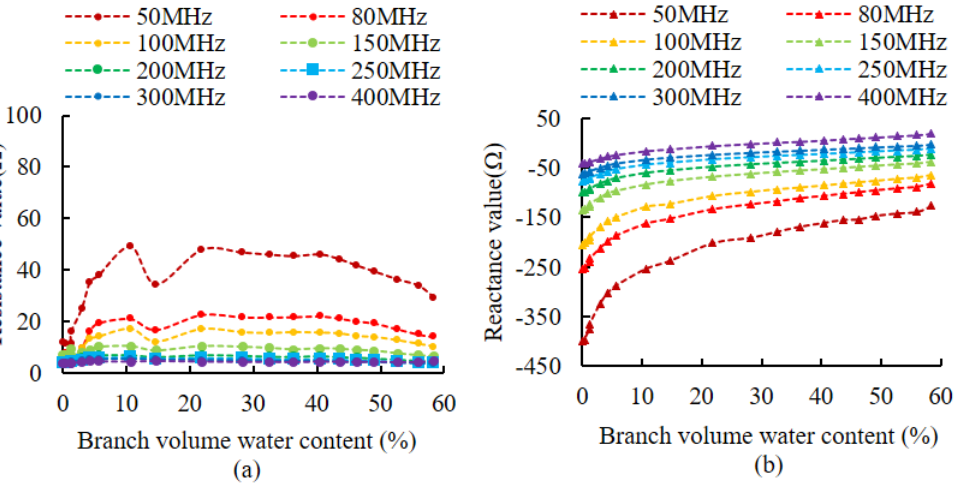
Figure 8. The variation of the impedance of the live wood branches. ( a ) The variation of the resistance component. ( b ) The variation of reactance components.